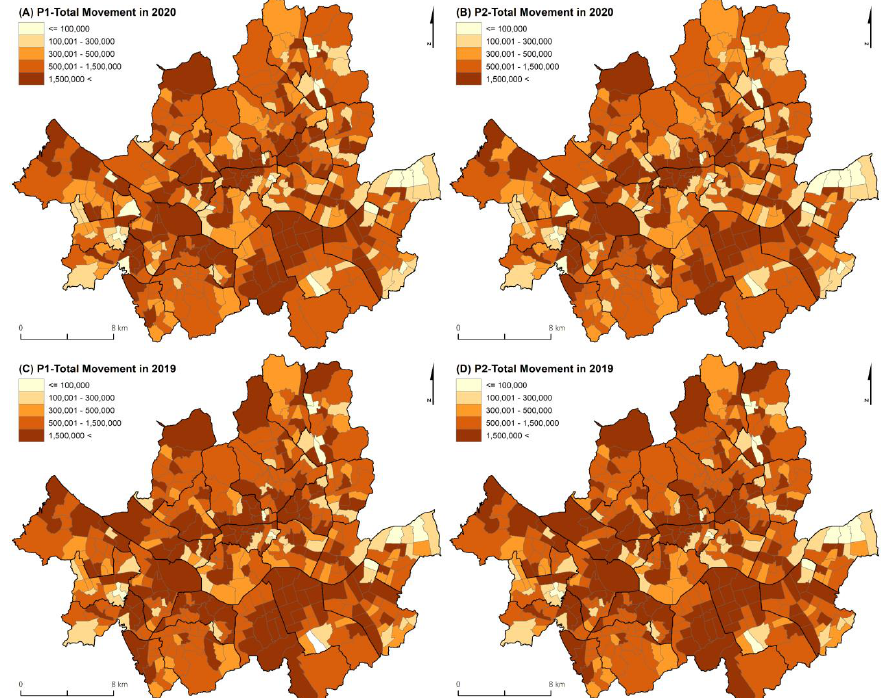
Figure A1. Numbers of alighting population in 2019 for P1 ( A ) and P2 ( B ), and in 2020 for P1 ( C ) and P2 ( D ).